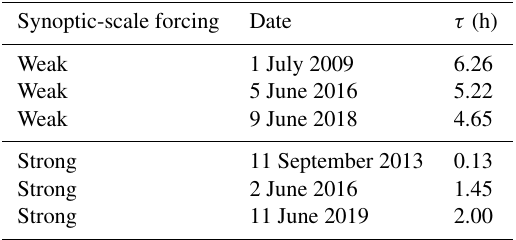
Table 2. List of case studies and convective adjustment timescale τ